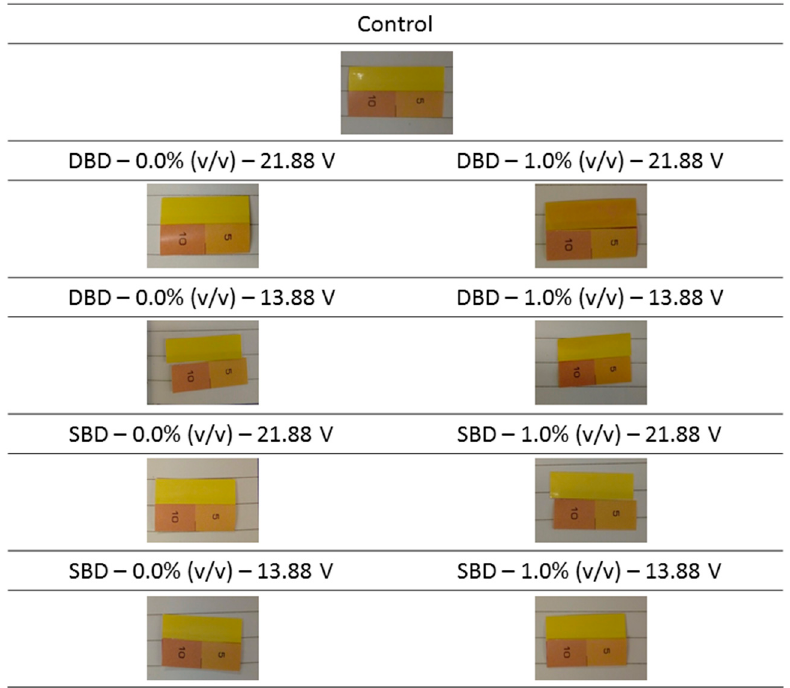
Figure 2. Generation of UV light monitored using UV-TEC strips ( n = 1). All UV-TEC strips, apart from the control, were exposed to CAP for 10 min using each possible combination of plasma characteristics. Afterwards, the color of the (un)treated strips was compared with the provided color scale bars, with each color corresponding to a certain UV intensity (5 = 5 mJ/cm² and 10 = 10 mJ/cm²).